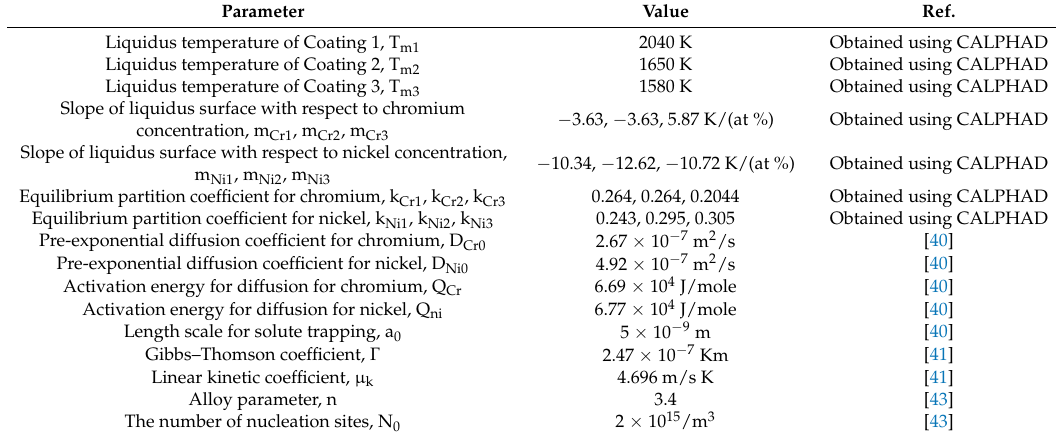
The number of nucleation sites, N 0